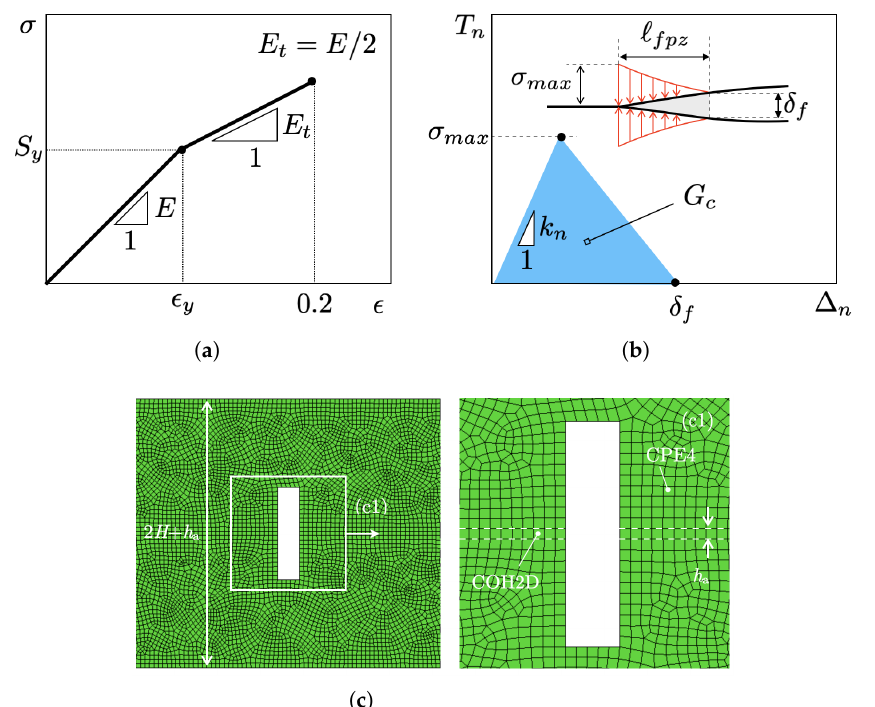
Figure 3. ( a ) Schematic stress–strain ( σ − (cid:101) ) diagram; ( b ) bilinear traction–separation relation em- ployed in FE simulations of crack growth - the insert highlights cohesive tractions acting across the crack faces within the fracture process zone; ( c ) details of an exemplary FE mesh ( w / H = 1/6). ( c1 ) Close-up view of the FE mesh around a